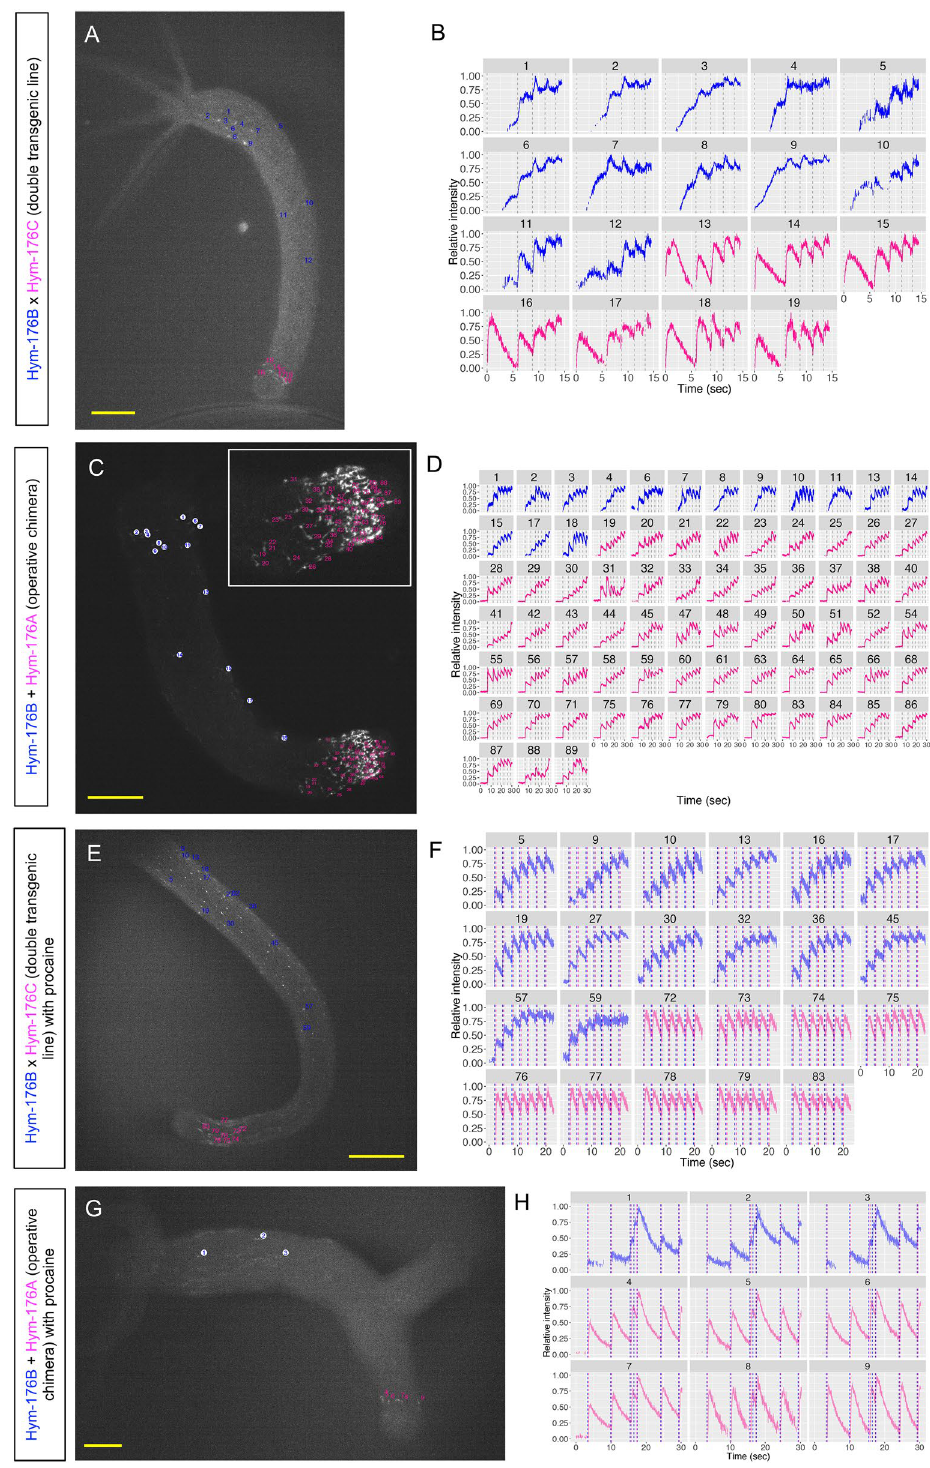
Figure 3. Simultaneously visualized neuronal activity of body and foot circuit. Double transgenic line of Hym-176B::GCaMP and Hym-176C::GCaMP with ( E,F ) or without ( A,B ) procaine treatment. The operative chimera of Hym-176B::GCaMP and Hym-176A::GCaMP with ( G,H ) or without ( C,D ) procaine treatment. Position of tested neurons ( A,C,E,G ). Neuronal activity (normalized intensity of GCaMP) with vertical dashed black lines indicating coactive neuronal excitation of both circuits (( B ) 0, 5.84, 8.71, 11.11, 13.19 s; ( D ) 6.42, 11.99, 16.28, 19.08, 22.31, 25.61, 28.85 s). Neuronal activity (normalized intensity of GCaMP) with vertical dashed lines indicating coactive body neuron excitation in blue (( F ) 1.94, 4.74, 7.94, 10.66, 13.32, 16.40, 19.42 s; ( H ) 3.25, 9.84, 15.30, 16.31, 17.28, 23.92, 29.00 s) and coactive foot neuron excitation in red (( F ) 2.39, 5.16, 8.42, 11.11, 13.79, 16.78, 19.81 s; ( H ) 3.53, 10.09, 15.65, 17.16, 24.13, 29.21 s). The number in the strip and the color of the excitation profile for each animal correspond to cells in each one of ( A,C,E,G ) (body neuron circuit in blue and foot neuron circuit in red). Bar: 100 µm in ( A,E,G ) and 200 µm in ( C